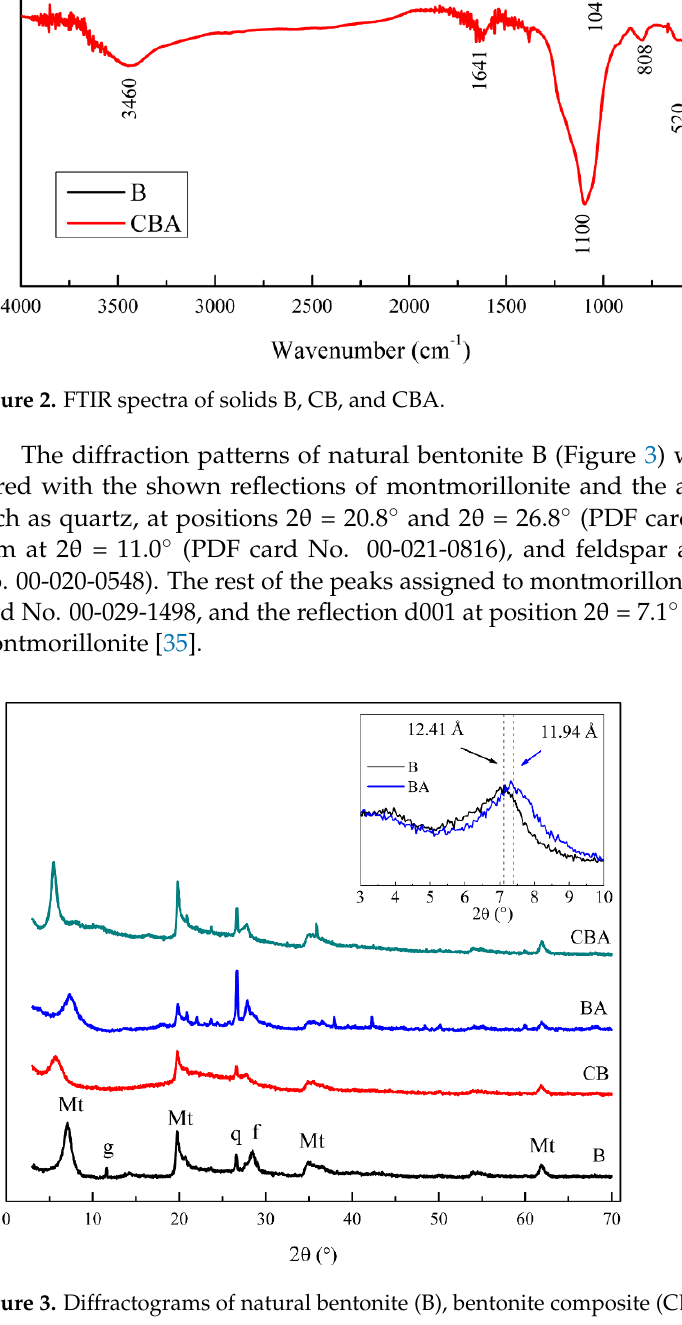
shifted to lower angles, from 2  = 7.1° to 2  = 5.6°, indicating the expansion of the inter-